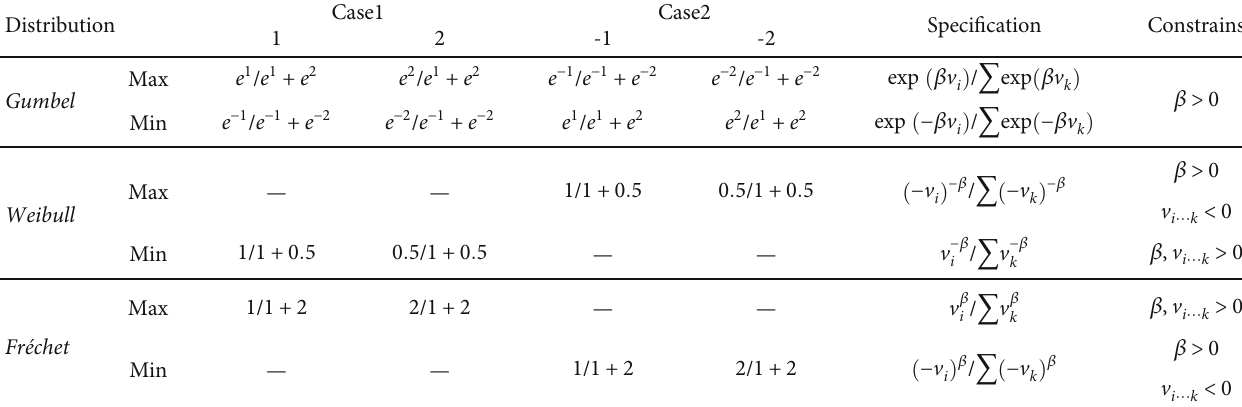
Table 6: Di ff erent calculations of three extreme value distributions under maximum and minimum theory.